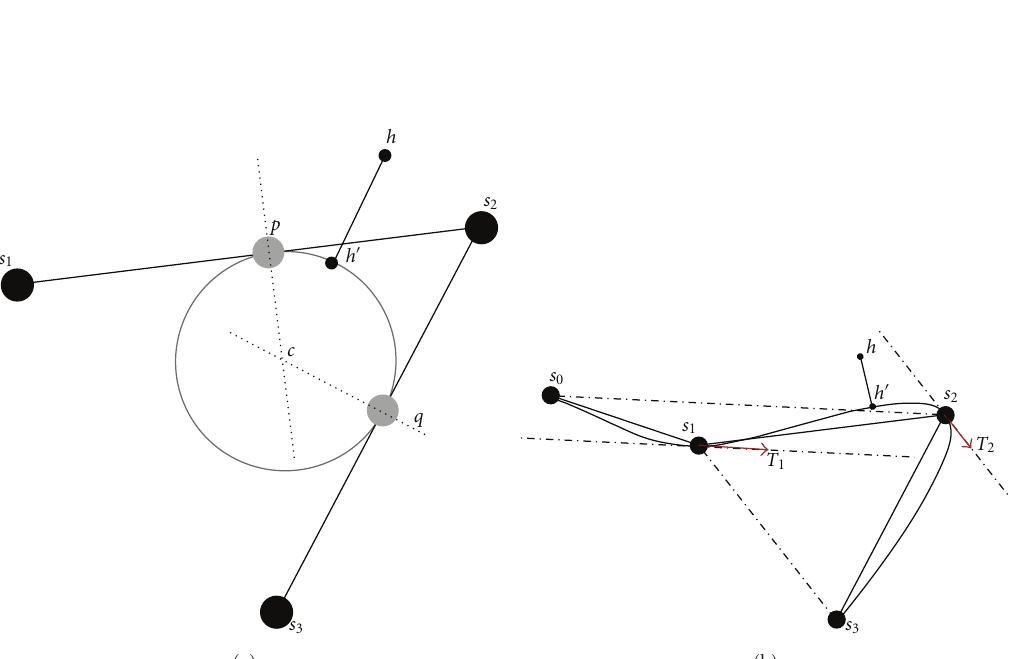
Figure 1: (a) First solution using rounded polygons. (b) Second alternative using cardinal